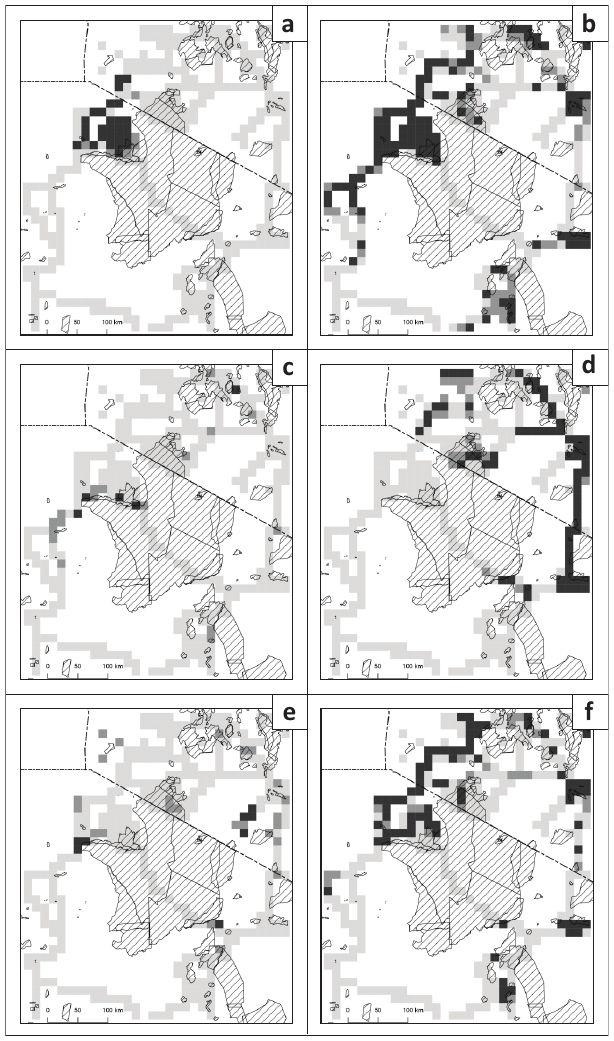
Grid cells are approximately 14 × 14 km. Surveyed cells where the species was not found are shaded light grey, while dark grey indicates presence and black indicates abundant and/or spreading invasions. FIGURE 4: Distribution of six invasive alien plant species, (a) Chromolaena odorata , (b) Lantana camara , (c) Opuntia stricta , (d) Parthenium hysterophorus , (e) Prosopis species and (f) Tithonia diversifolia , in and around the Serengeti- Mara ecosystem, East Africa.